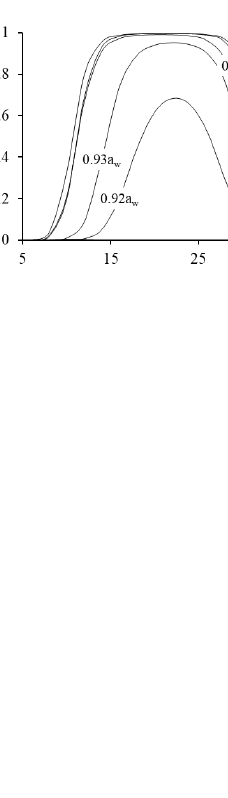
probability for growth is p = 0.5 in the range of 22 – 27 °C after 3 days, while in the same